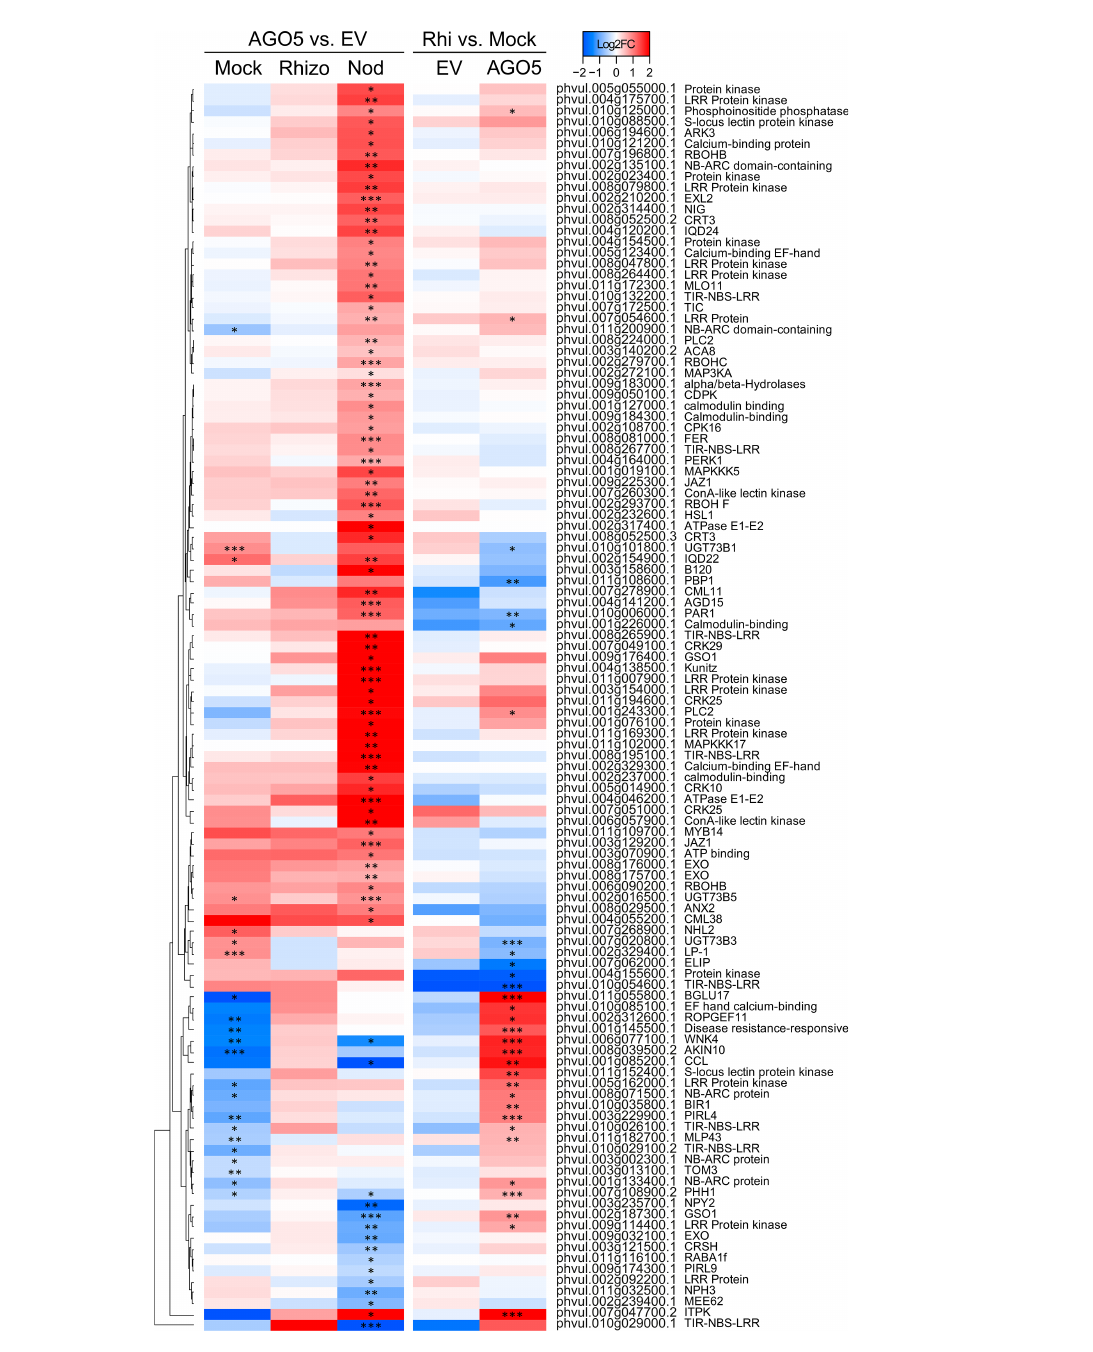
FIGURE 5 Down-regulation of PvAGO5 increases the expression of plant-defense related genes. Heatmap showing Log2 fold-change of gene transcripts involved in plant defense response in uninoculated- (Mock) and rhizobia-inoculated roots (rhizobia), as well as in mature nodules (Nod). Genes showing higher and lower expression differences are shown in different shades of red and blue, respectively. Labels at the top of the heatmap located on the left side indicate: Mock= uninoculated transgenic roots; Rhizo= rhizobia-inoculated transgenic roots, and Nod = mature nodules. In both cases the comparison between PvAGO5- RNAi vs Empty Vector is shown. Labels at the top of the heatmap located on the right side indicate: EV= transgenic roots expressing the empty vector (control), and AGO5: transgenic roots expressing the PvAGO5- RNAi construct. In both cases the comparison of rhizobia-inoculated roots vs mock-inoculated roots is shown. Asterisks indicate different levels of statistical signi fi cance of the comparisons (*: adjusted P-value<0.05; **= adjusted P-value<0.01; ***= adjusted P-value<0.001). Genes with no asterisk are not signi fi cantly differentially expressed. Dendrogram (left) represents the transcript clustering based on expression pro fi